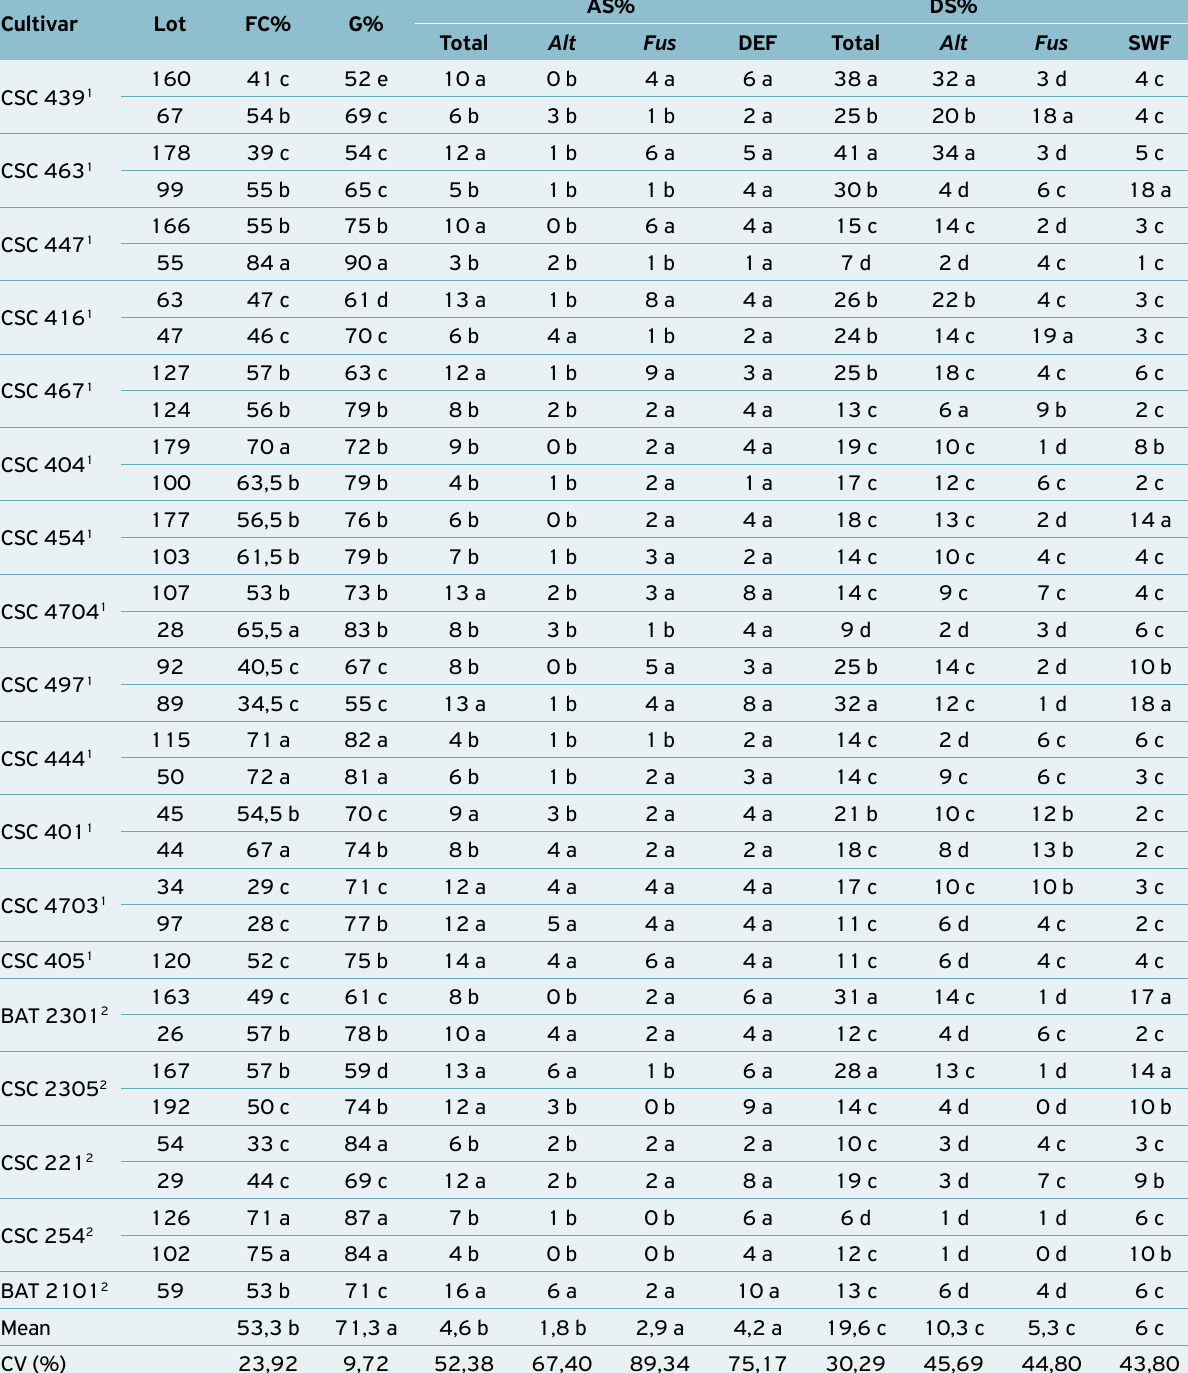
Table 2. First count (FC%), germination (G%), abnormal seedlings (AS%) and fungi incidence; dead seeds (DS%) and fungi incidence, in the germination test of tobacco seeds from the 2012/2013 crop, produced by the enterprise Souza Cruz S/A. Cultivar